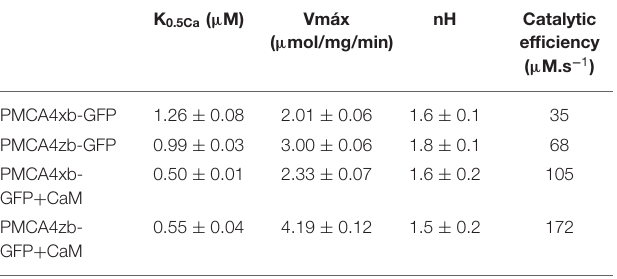
TABLE 1 | Comparison of the Ca 2 + dependency of purified PMCA4 isoforms.